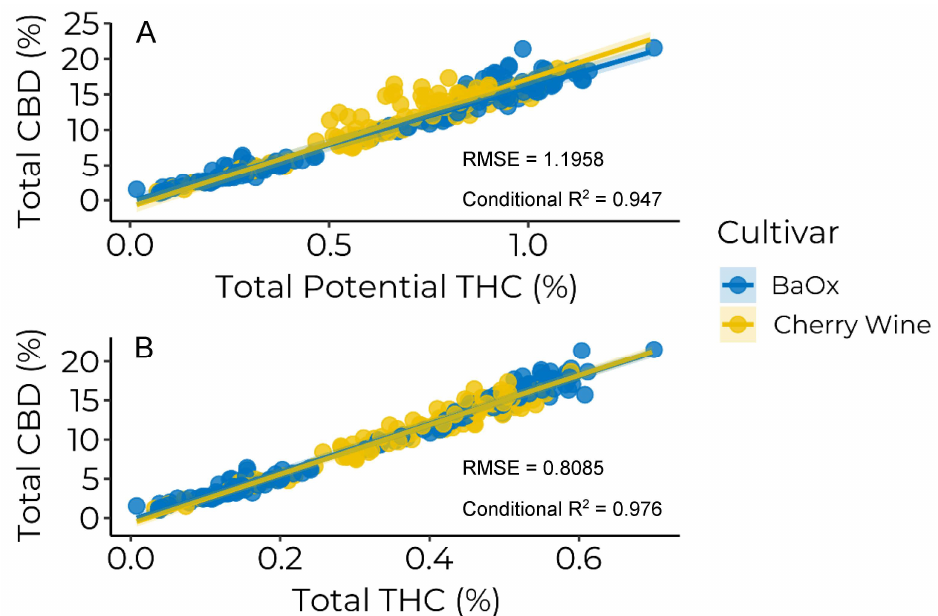
Figure 4. Linear regression for the effect of cultivar and total potential THC ( A ) and total THC ( B ) on total CBD. Total potential THC concentration calculated as ∆ 9 -THC + 0.877 × THCA + CBN, total THC concentration calculated as ∆ 9 -THC + 0.877 × THCA. Shaded area represents 95% confidence interval for the predicted model. Circles represent plot-level data points. RMSE = Root Mean Square